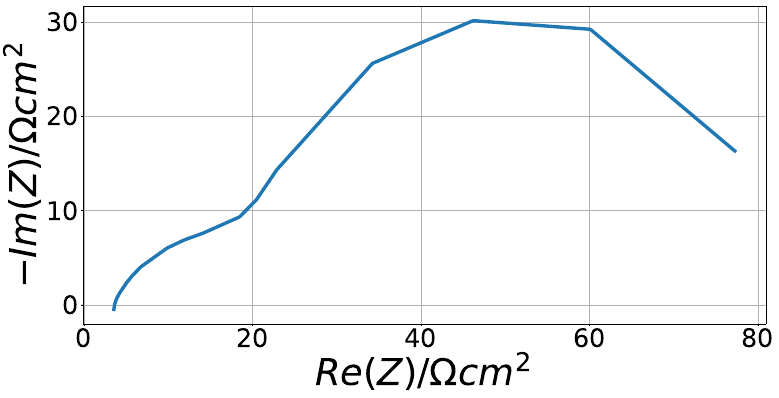
Figure 9. Solid oxide fuel cell characteristic—measured